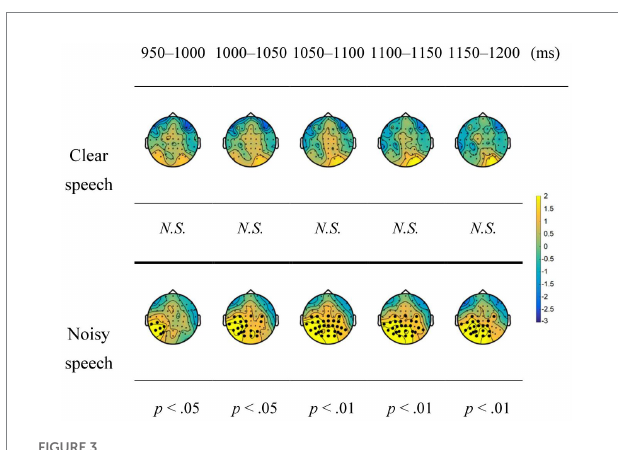
FIGURE 3 Topographic maps for the predictability effect on the late positive component (LPC) under the clear and noisy conditions in a moving time window analysis. Black dots represent the electrodes that show significant differences in the contrasts. N.S., not significant.